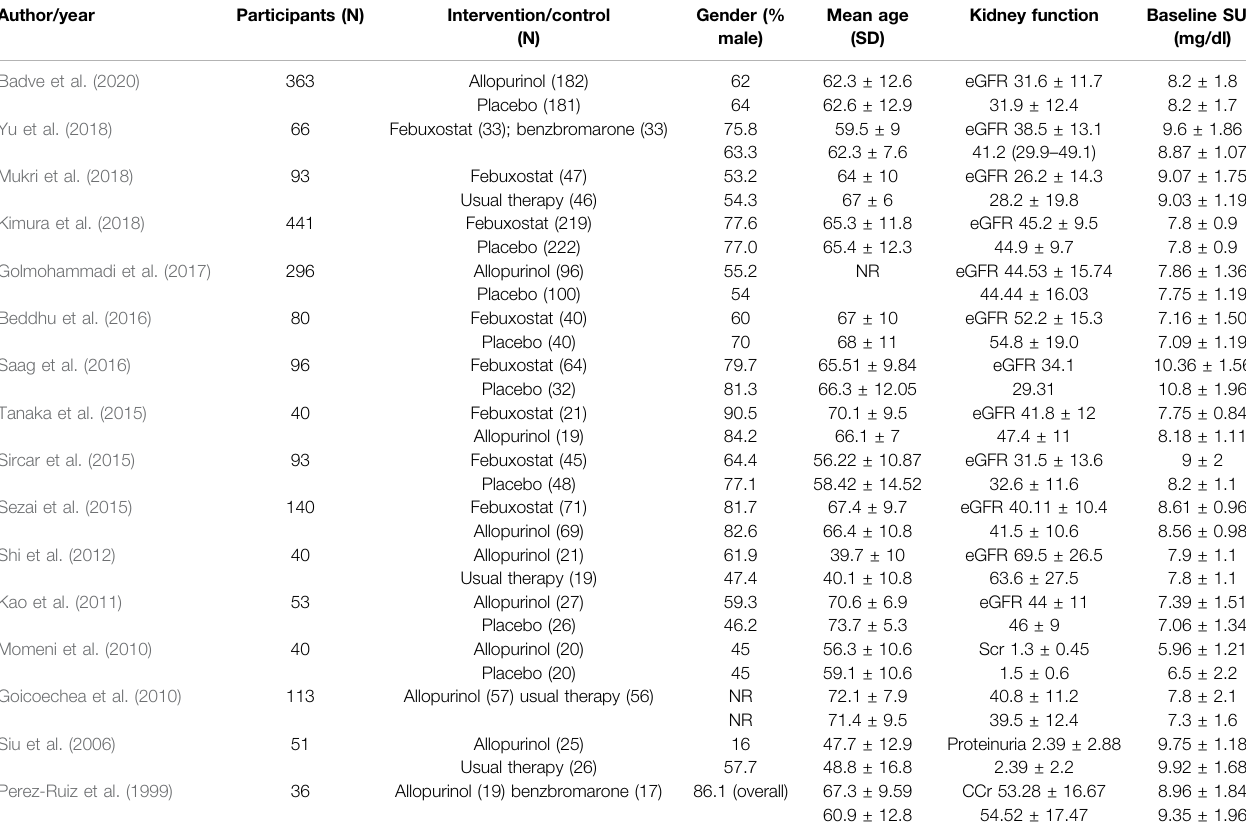
TABLE 2 | Baseline characteristics of included